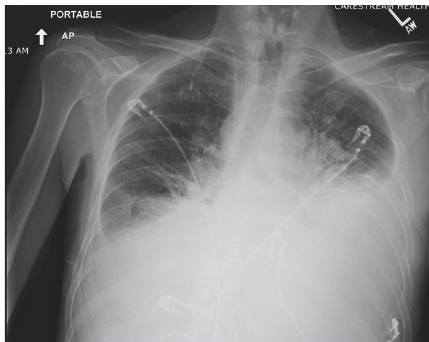
Figure 2: A transthoracic echocardiogram illustrating an apical four-chamber view of the patient’s heart during diastole illustrating right ventricular free wall collapse.